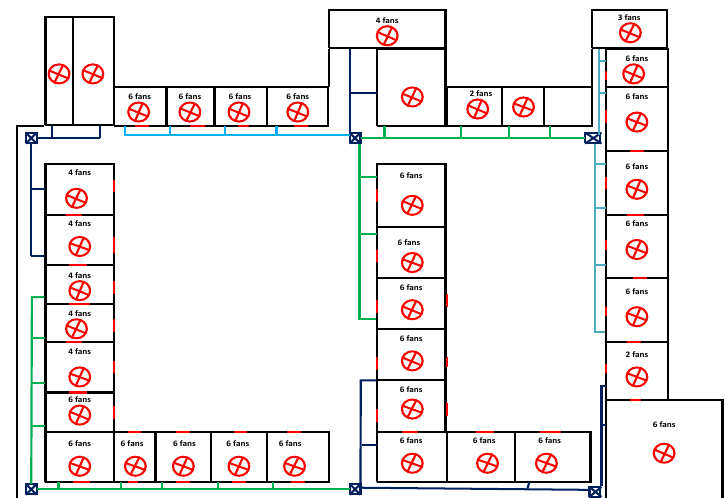
Figure 17. Proposed model for the Academic Block.